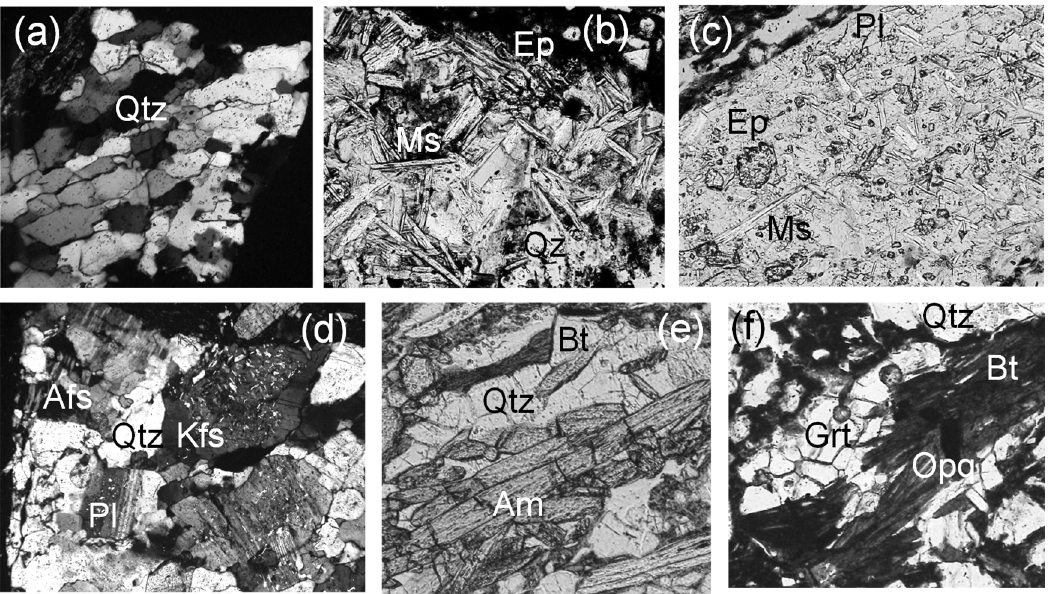
Figure 5. Photomicrograph of rock fragments in pottery samples (plane-polarized polar). The vertical sizes are 200 μ m. ( a ) Fragment of quartz aggregate with undulatory extinction. ( b ) Pelitic or basic schist. ( c ) Pelitic or basic schist. ( d ) Metagranitoids or granitic rocks. ( e ) Basic schist or amphibolite. ( f ) Garnet gneiss. Abbreviations: Qtz—quartz; Ep—epidote; Ms—muscovite; Pl—plagioclase; Afs—alkali feldspar; Kfs—potassium feldspar; Bt—biotite; Am—amphibole; Grt—garnet; Opq—opaque.